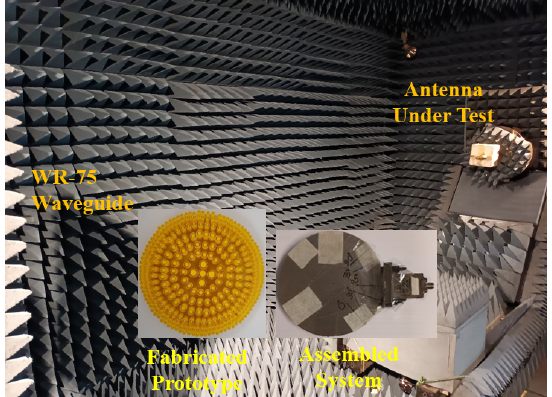
Figure 8. Measurement system setup in anechoic chamber. Attached index figures shows fabricated prototype and assembled system with parallel plates and